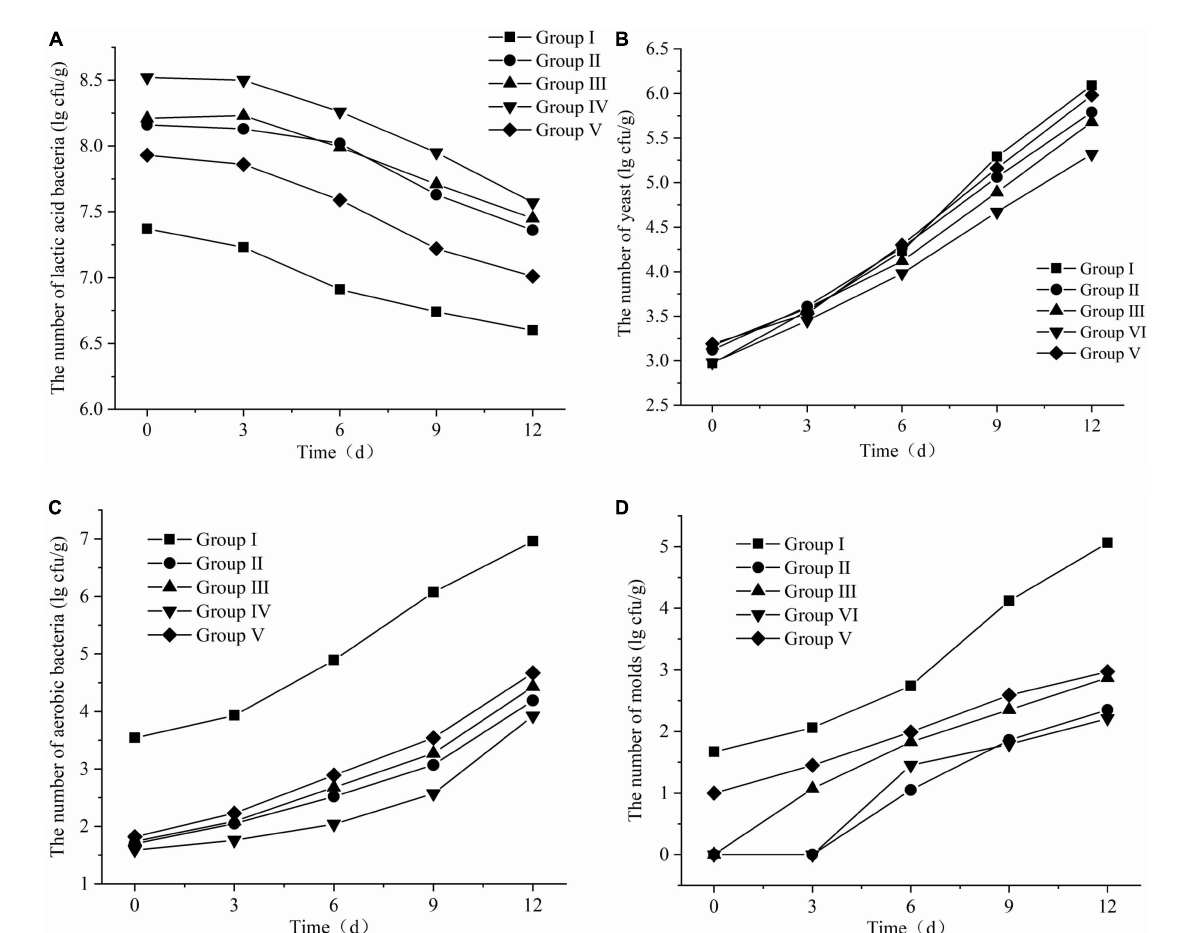
FIGURE5 Changes in microbial of fermented total mixed ration (FTMR) during the aerobic period. (A) Lactic acid bacteria, (B) yeasts, (C) aerobic bacteria, and (D)